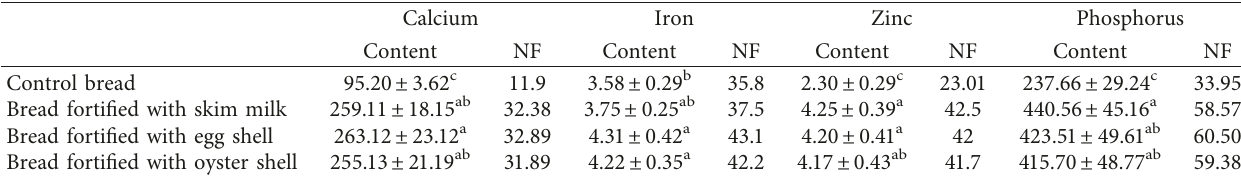
Table 6: Calcium, iron, zinc, and phosphorus contents in the control bread and breads fortified with skim milk and egg shell and oyster shell powders.